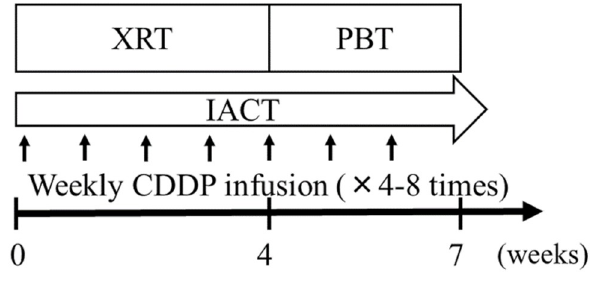
Figure 2. Treatment schedule. XRT, X-ray therapy (36–40 Gy in 20 fractions); PBT, Proton beam therapy (28.6–33.0 Gy in 13–15 fractions); IACT, intra-arterial infusion chemotherapy; CDDP, cisplatin (20–40 mg/m 2 ).